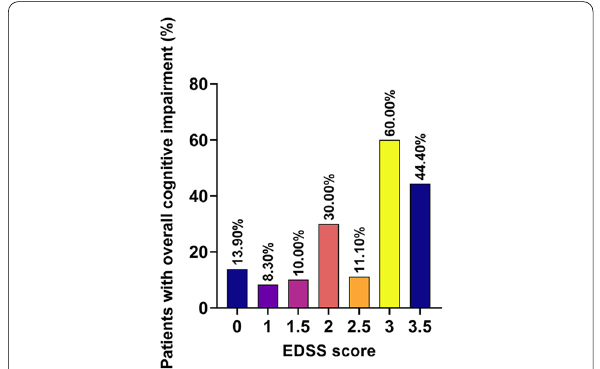
Fig. 1 The proportion of patients with cognitive impairment, based on the expanded disability status scale